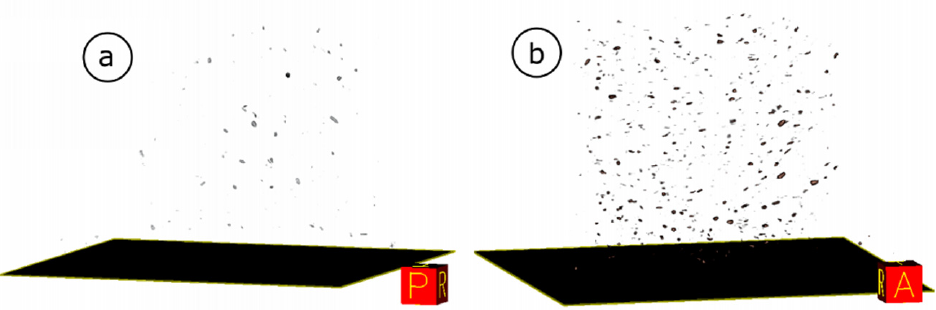
Figure 10. Image of foam with the addition of wood particles made with a computer tomograph: ( a ) a ) 5% WP addition; ( b ) 20 addition 5% WP addition; ( b ) 20 addition WP. (